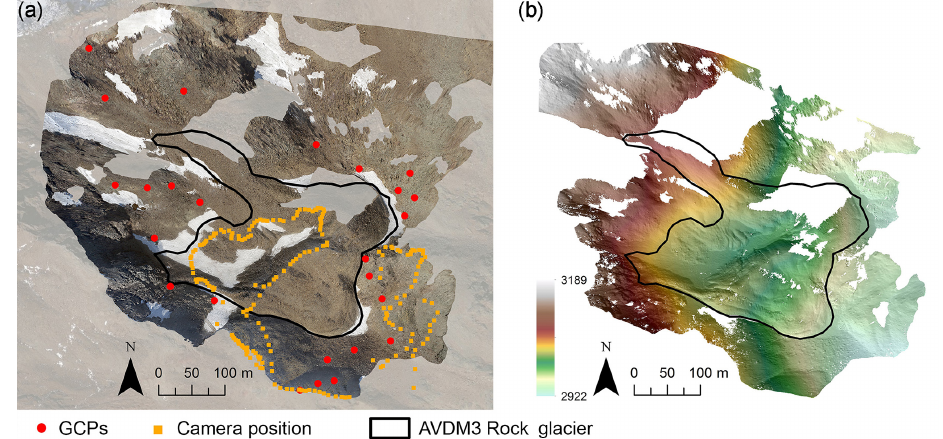
Figure 13. Correspondence between (a) the orthophoto of SfM–MVS 3-D model of rock glacier surveyed on 27 September 2014 and (b) the hillshade model overlain on colour-coded elevations of the rock glacier DEM calculated using the same data. The holes in the DEM are areas not reconstructed.